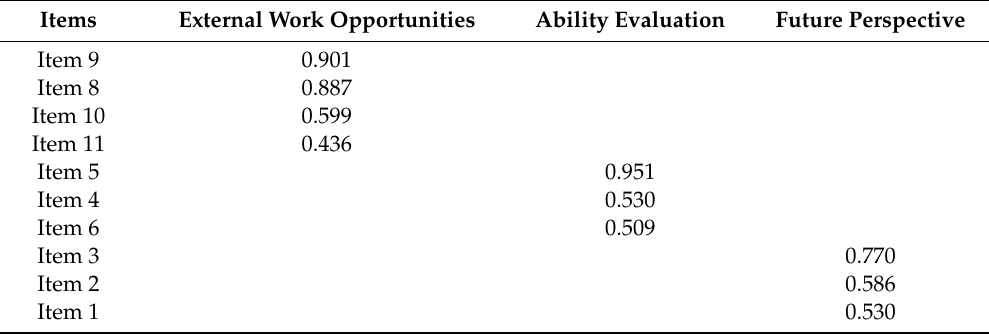
Table 2. Exploratory Factorial Analysis with factorial loadings 1